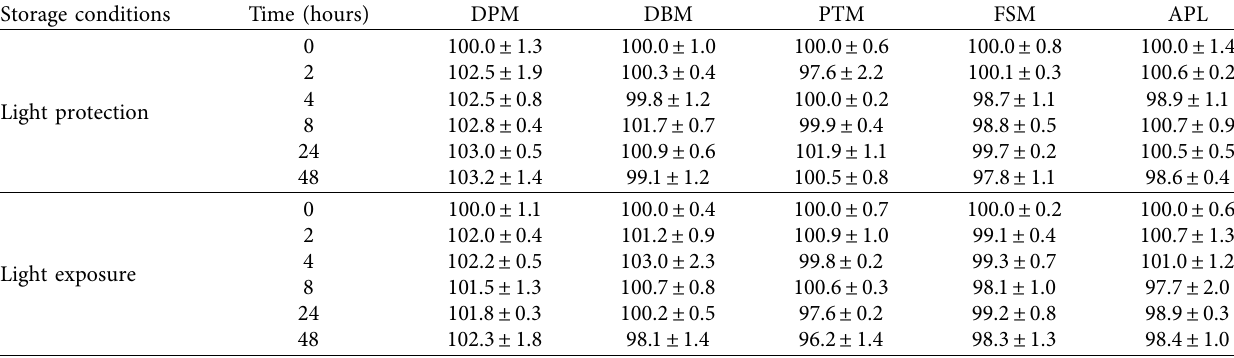
Table 6: Mean concentrations of DPM, DBM, PTM, FSM, and APL in 0.9% sodium chloride injection with light protection or light exposure at 25 ° C.